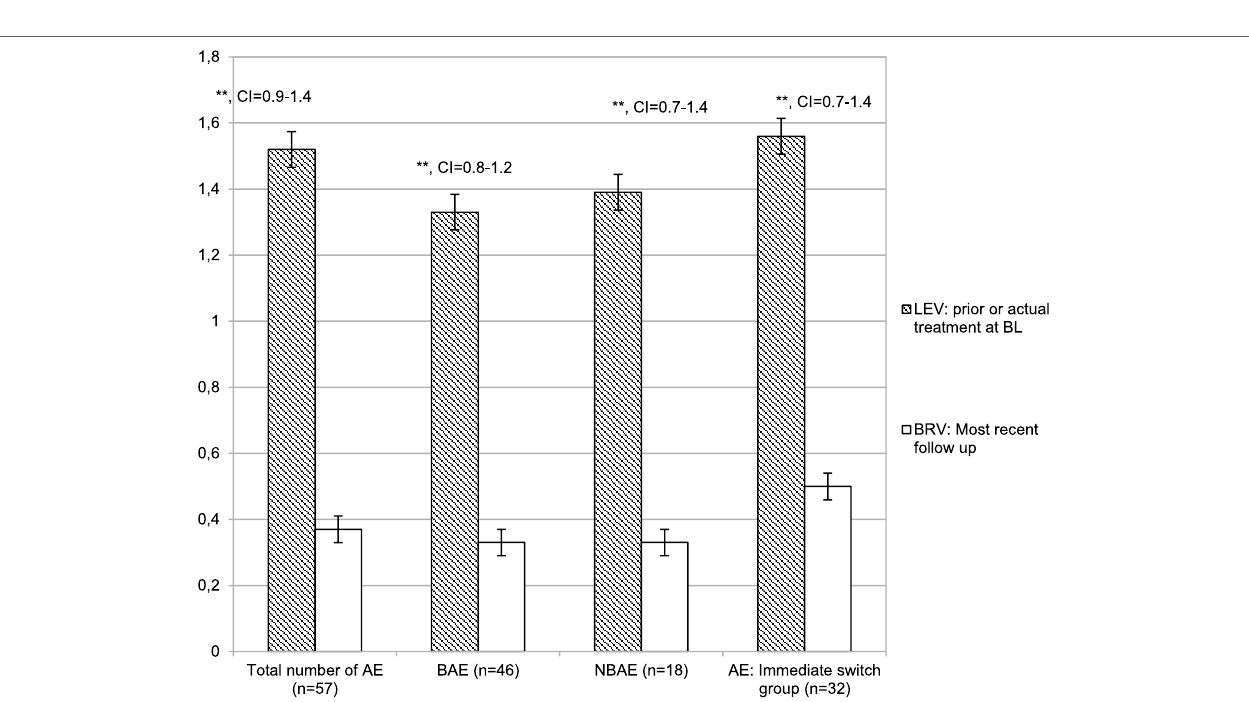
FigUre 2 | Number of adverse events: [total number and number of behavioral and non-behavioral adverse events (AE)] under Levetiracetam (LEV) treatment and under brivaracetam (BRV) treatment in the subpopulation of patients who ever (actual or in prior treatment) had AE under LEV medication. Thirty-two patients had been switched immediately from LEV to BRV. ** p < 0.001, and error bars indicate the mean error.